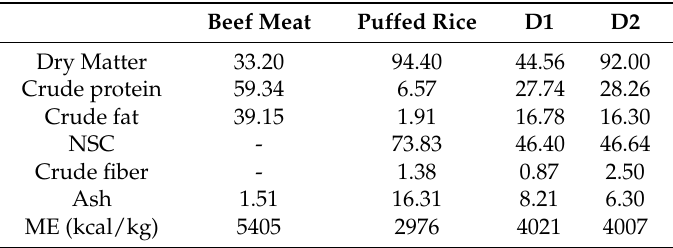
Table 1. Food and daily diet chemical composition (% on Dry Matter basis). D1: homemade diets based on puffed rice, beef meat and olive oil. D2: commercial dry food for adult